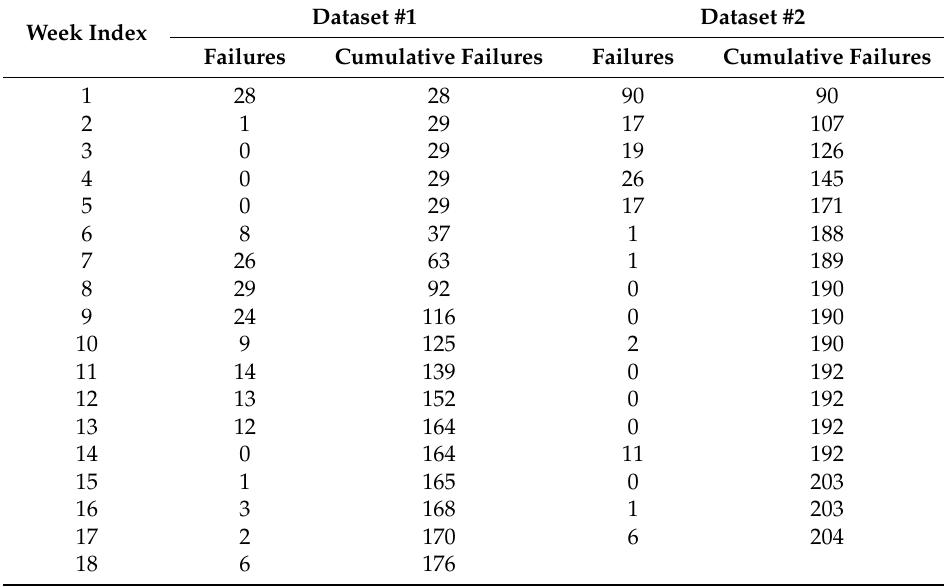
Table 3. Failure data of large medical record system (LMRS)—Dataset #1 and #2.